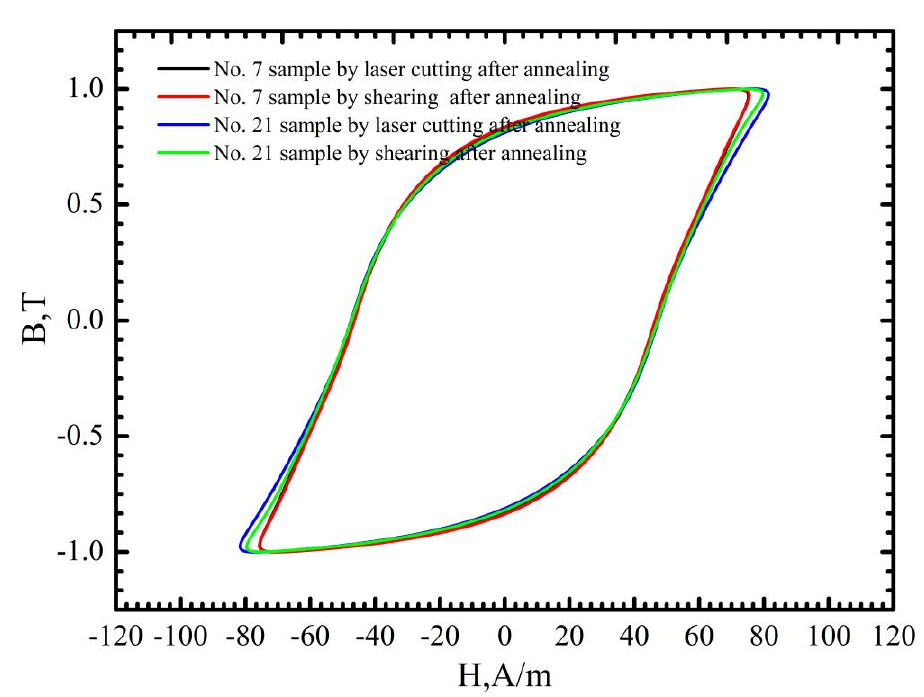
Figure 11. Hysteresis curves of No. 7 and No. 21 samples before and after annealing at the magnetic induction intensity of 1.0 T.